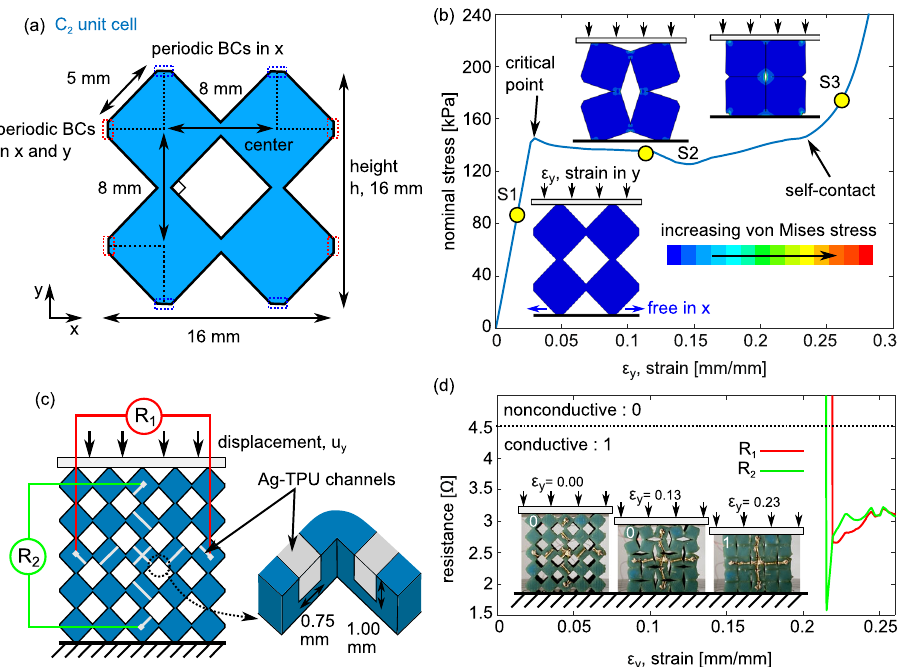
Fig. 2 Bit abstraction via open/closed circuit. a C 2 unit cell dimensions with periodic boundary conditions. b Simulated mechanical response of C 2 unit cell featuring three regimes of general behavior and shape change. c Schematic of C 2 metamaterial with Ag-TPU biaxial switch network. Resistance measurements R 1 and R 2 are monitored across two terminal pairs. d Experimental resistance measurement with photos depicting the deformations in the three compression